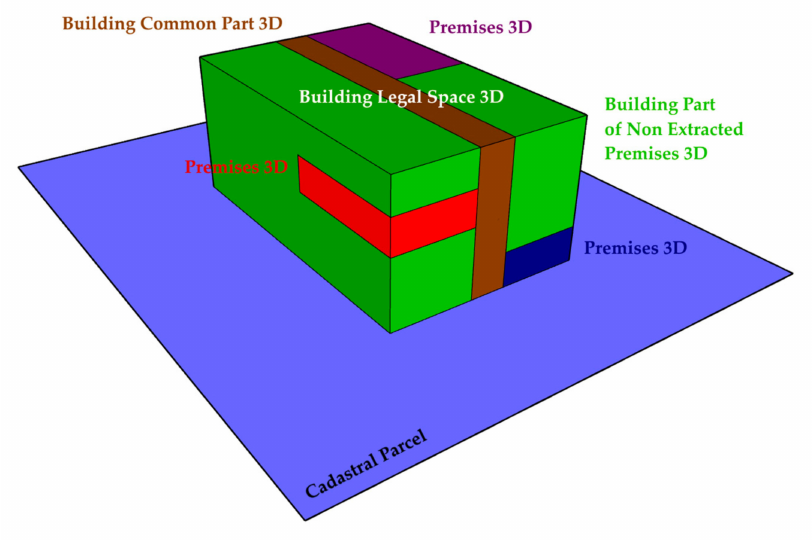
Figure 7. ‘Building Legal Space 3D’ including ‘Premises 3D’, ‘Building Common Part 3D’ and ‘Building Part of Non-Extracted Premises 3D’. Illustration of legal division.